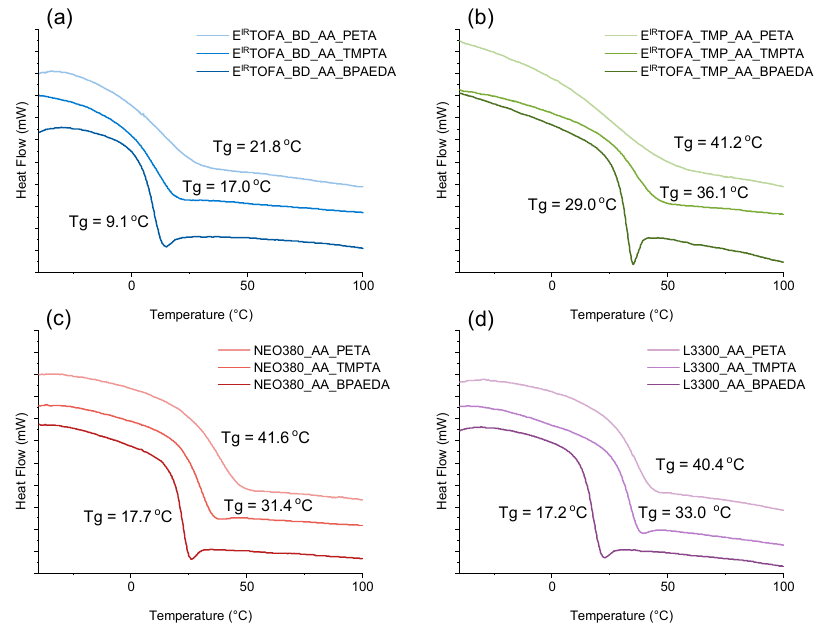
Figure 4. DSC curves of polymer monoliths from synthesized acetoacetates and BPAEDA, TMPTA, and PETA acrylates. ( a ) E IR TOFA_BD_AA polymers; ( b ) E IR TOFA_TMP_AA polymers; ( c ) NEO380_AA polymers; ( d ) L3300_AA polymers.